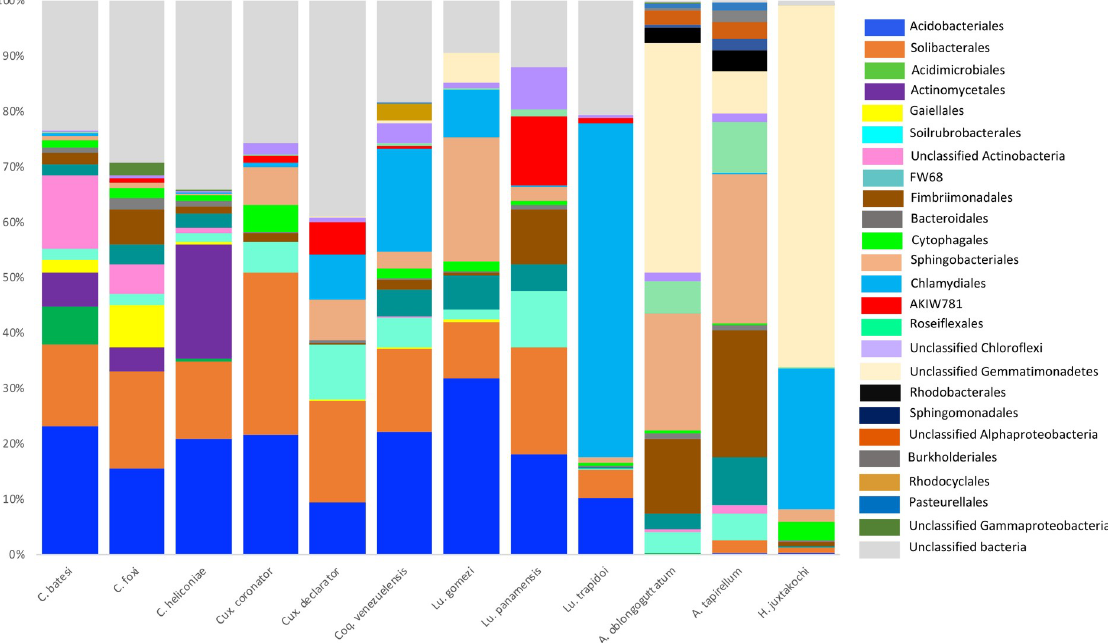
Fig 1. Relative abundances of bacterial orders above 0.1% summarized for each blood-feeding arthropod